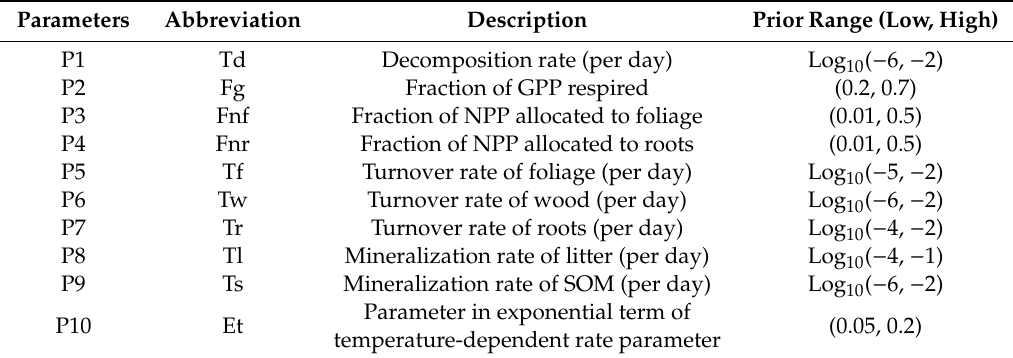
Table 2. DALEC model